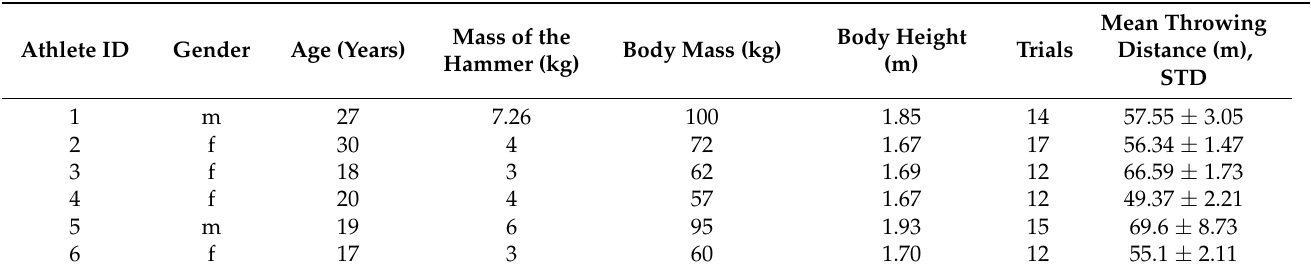
Table 1. Participating athletes’ characteristics, the number of trials evaluated (trials) and related mean throwing distance.